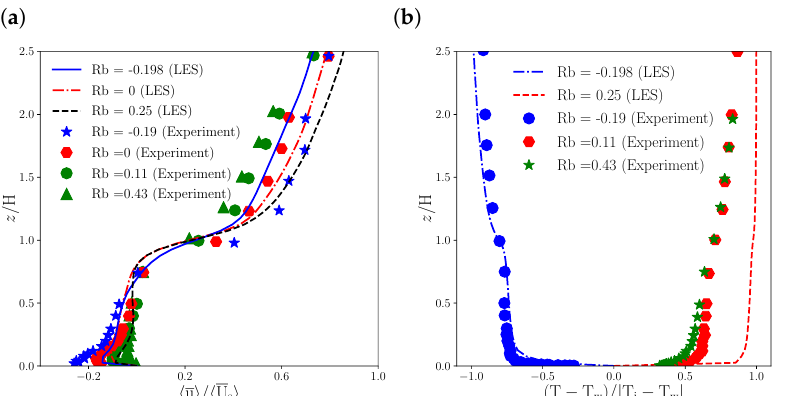
Figure 3. Validation of the LES model for stratified flow over a regular array against the wind-tunnel data of Uehara et al. [58]: ( a ) streamwise velocity; ( b ) temperature. The bulk Richardson number Rb is defined in Equation